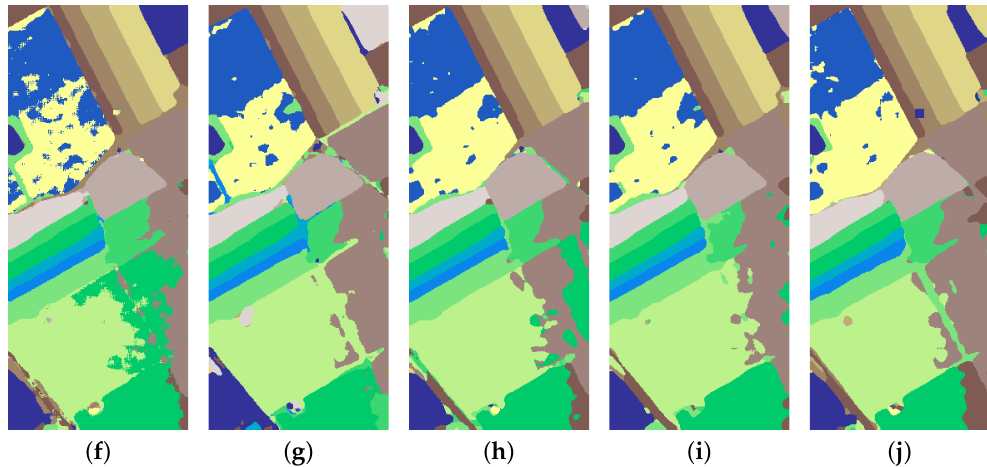
Figure 15. Classification maps for the SV dataset. ( a ) SVM (OA = 85.9%). ( b ) EMP (OA = 92.6%). ( c ) DenseNet (OA = 94.0%). ( d ) DPRN (OA = 93.6%). ( e ) FDMFN (OA = 93.9%). ( f ) MSRN (OA = 93.1%). ( g ) LWRN (OA = 94.5%). ( h ) SSSERN